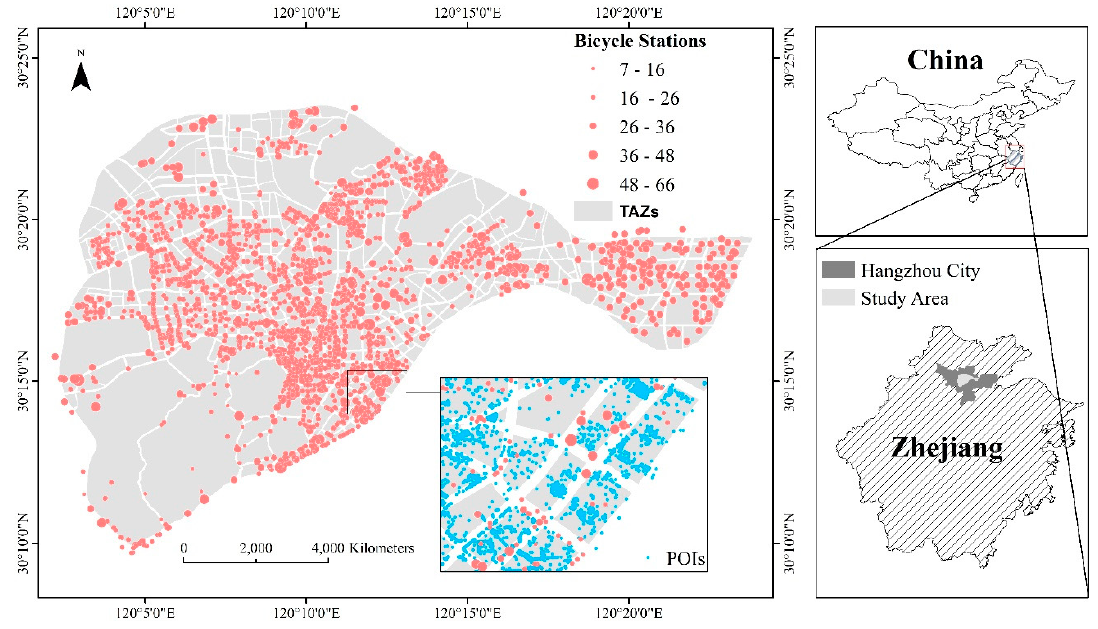
Figure 1. The spatial distribution of bicycle stations and collection of POIs in the study area (2017).